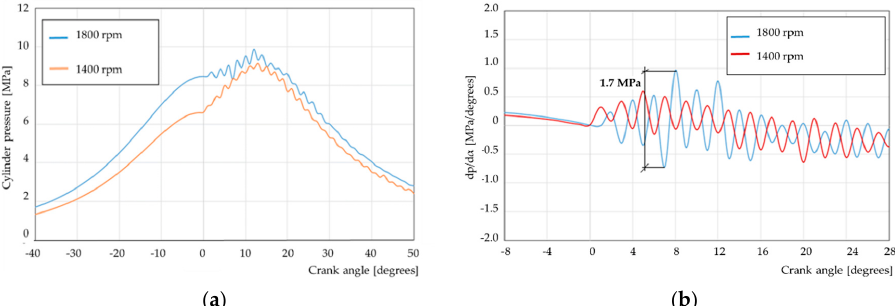
Figure 4. The course of changes: ( a ) The pressure in the combustion chamber along with the knocking combustion symptoms; ( b ) oscillation of pressure dp/d α of the working medium resulting from knocking combustion in the combustion chamber; when the engine was powered by diesel oil and 40% of biogas, for 80% load of engine and two rotational speeds of the engine crankshaft (1400 and 1800 rpm). Reproduced from [48], Polish Scientific Society of Combustion Engines: 2015.